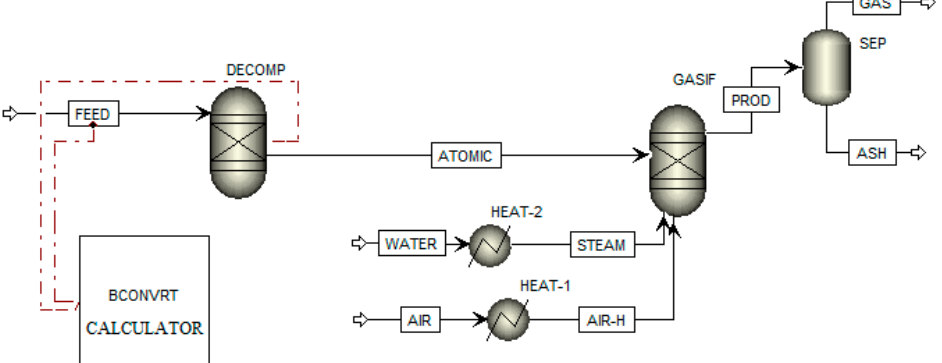
Figure 1. Flow-diagram for the non-stoichiometric biomass gasification